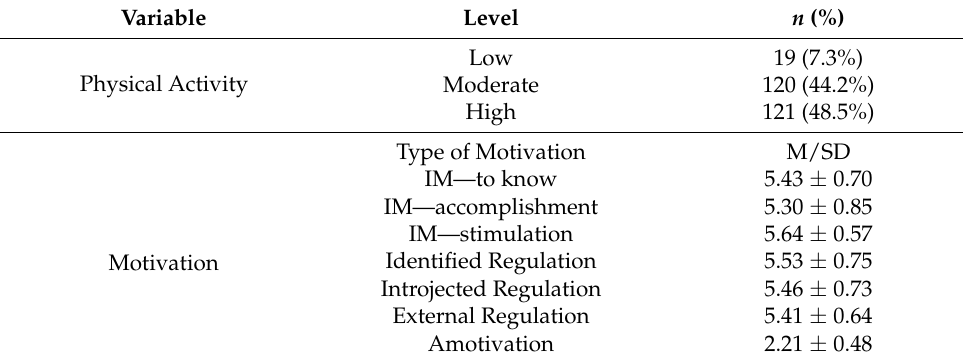
Table 2. Levels of Physical Activity and Motivation.